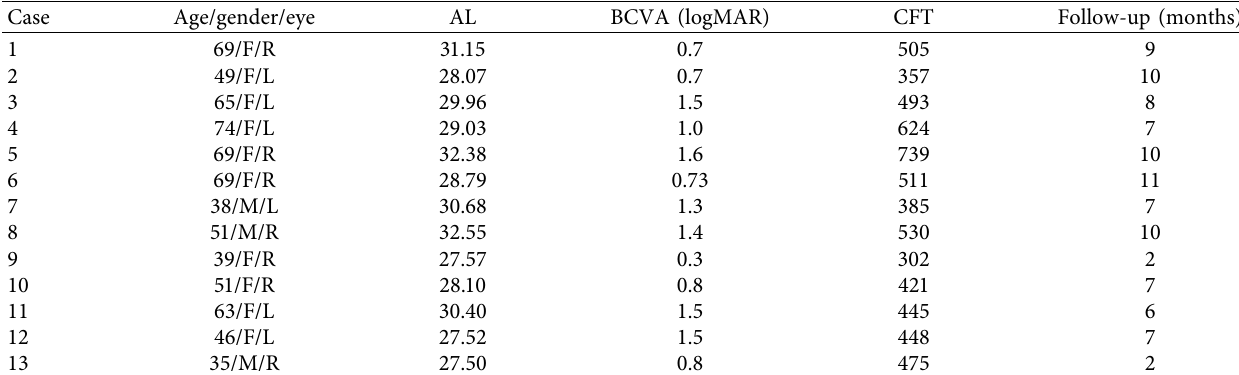
Figure 1: Schematic drawings and surgical video screenshots. ILM stained with indocyanine green ((a), (A)). Foveal ILM with a flag retained during peeling off ILM ((b), (B)). The flag inverted to structure double-layer ILM on the surface of the fovea ((c), (C)). Table 1: Preoperative demographic.